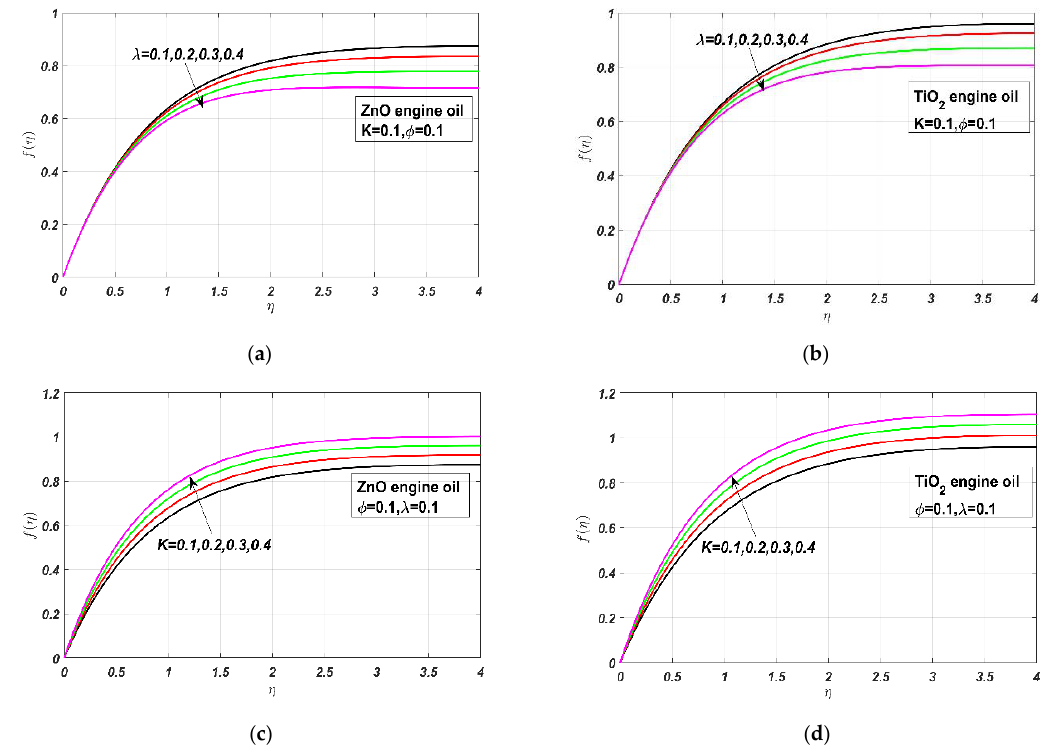
Figure 4. The impact of rotation parameter λ ( a , b ) and slip parameter K ( c , d ) on the velocity profile f ( η ) for ZnO and TiO 2 engine oil nanofluids.